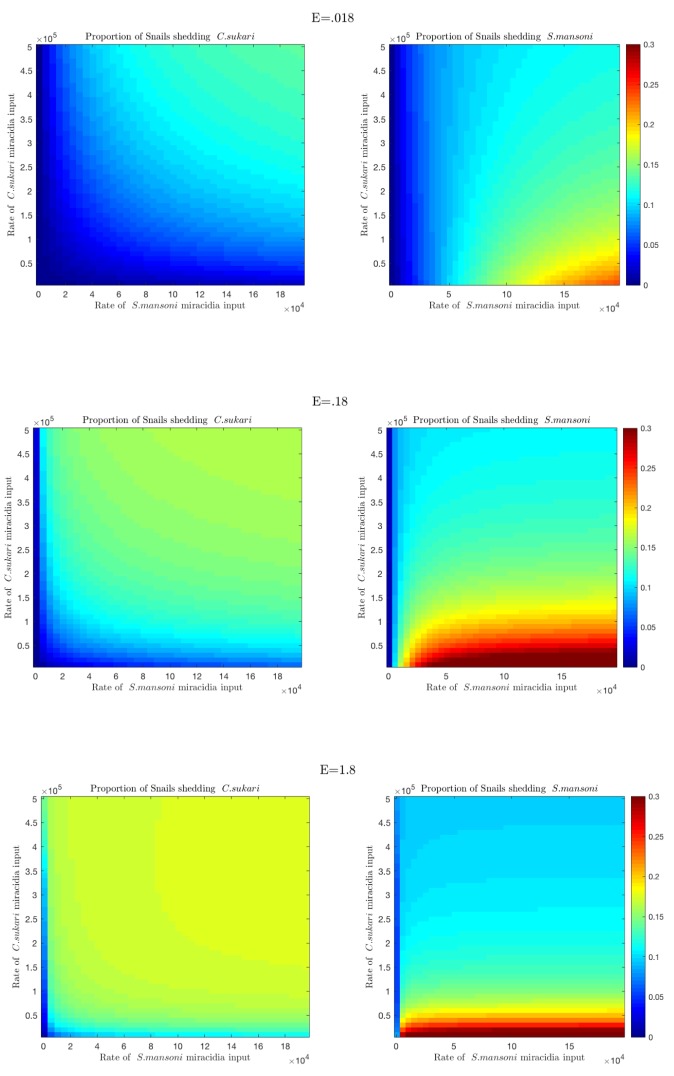
The proportion of snails shedding S. mansoni and C. sukari under a range of miracidial inputs and exposure rates.The impact of miracidial input levels on the proportion of snails shedding each parasite and the miracidial input levels which result in levels seen in our field data vary with B. pfeifferi exposure rates.